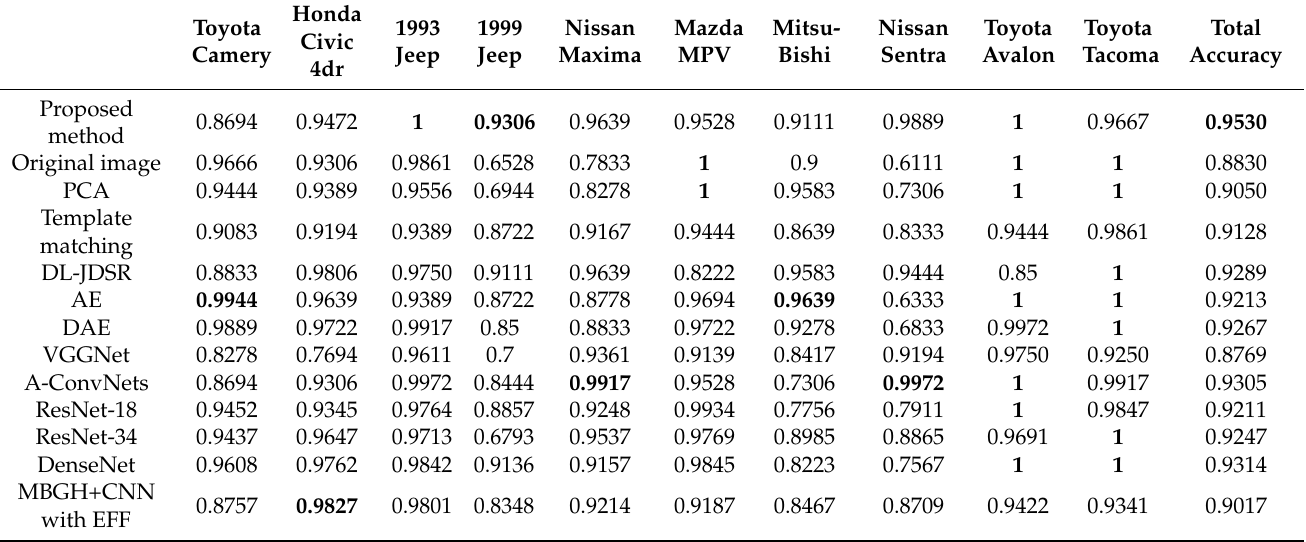
Table 10. Detailed Accuracies of Different Types on Civilian Vehicle Data via Some SAR Recognition